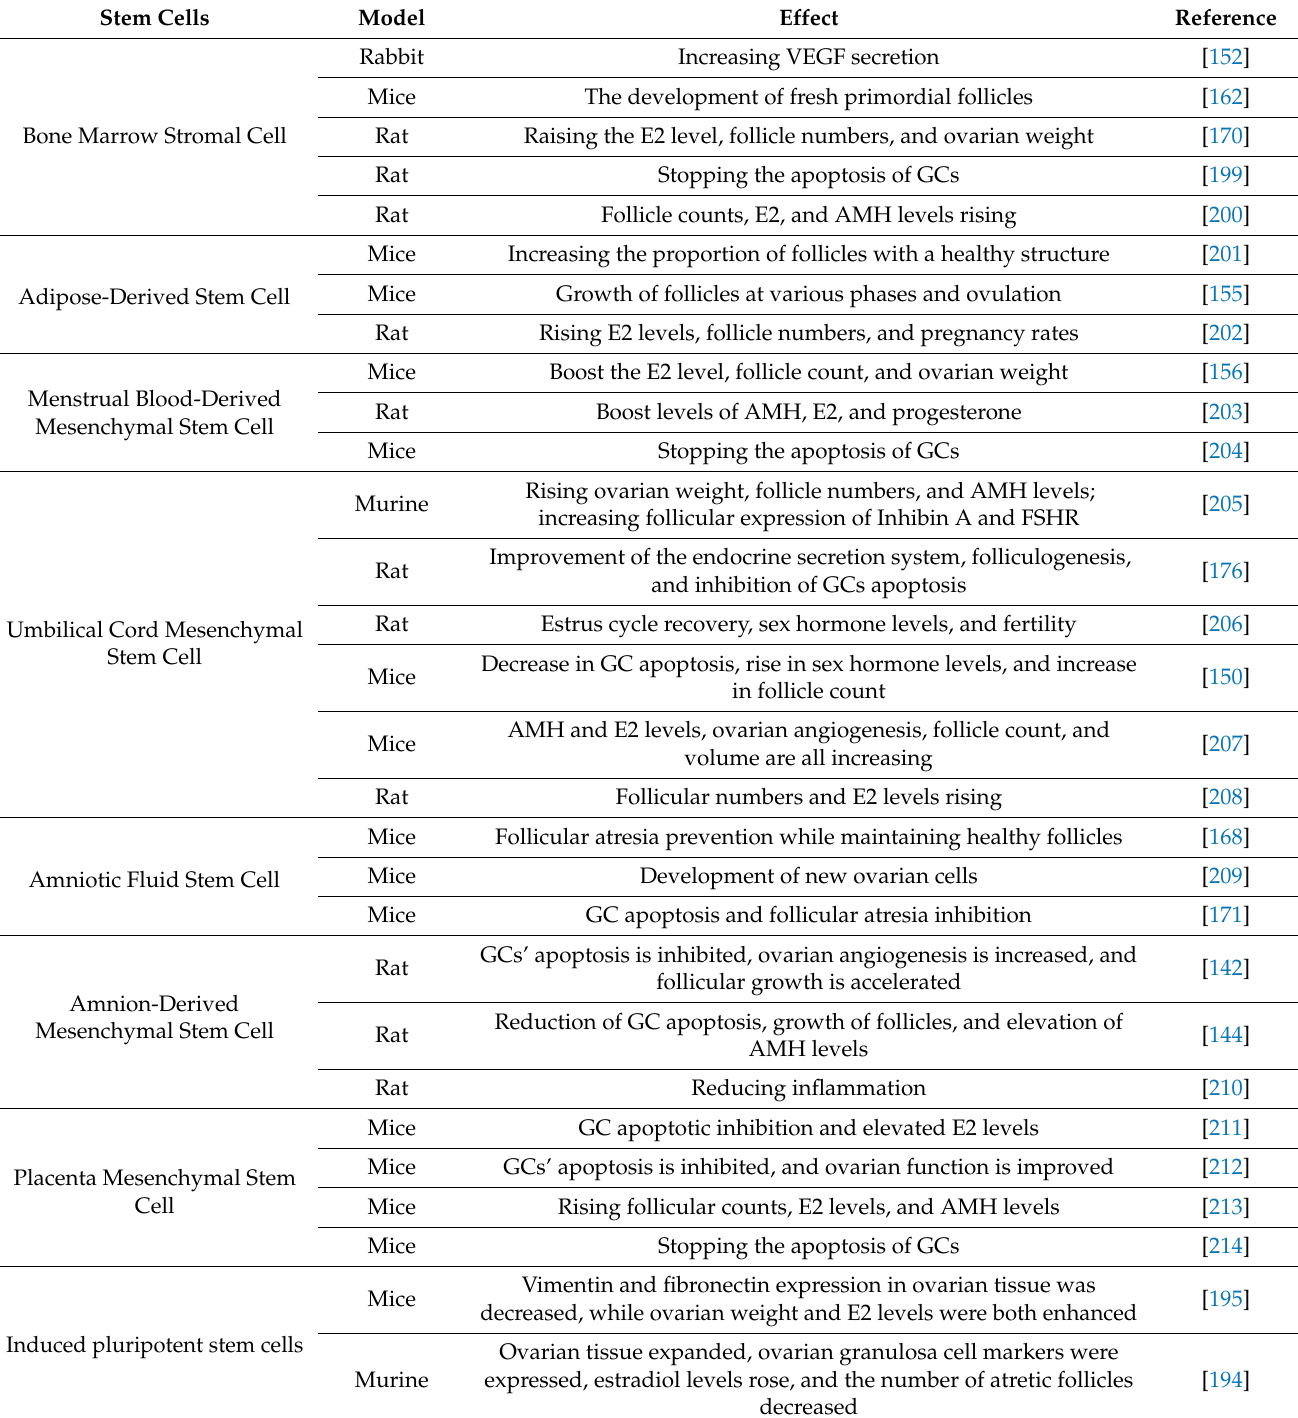
Table 1. Different types of stem cells used for the treatment of POF in animal